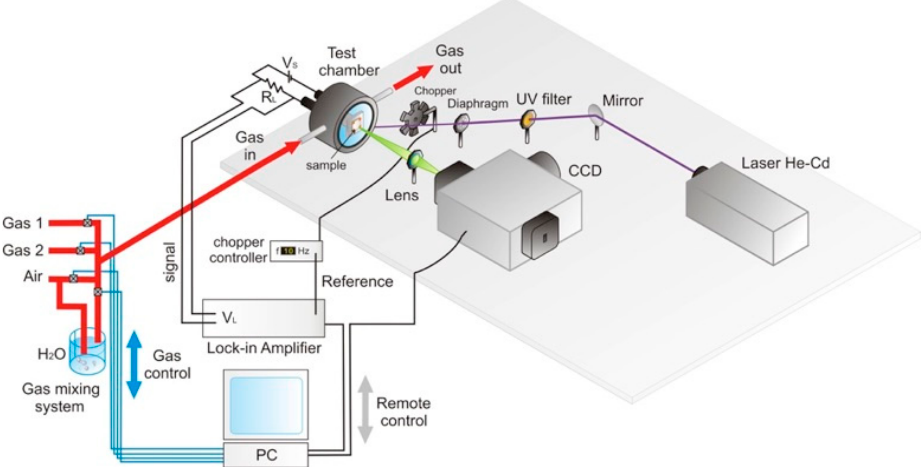
Figure 2. Sketch of the experimental setup.